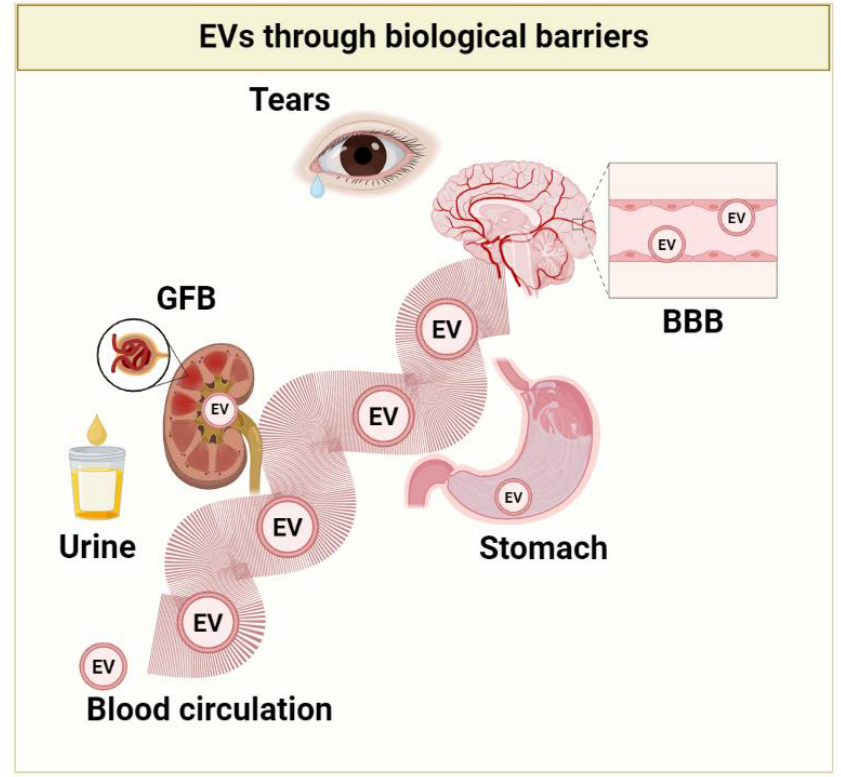
Figure 2. Summary of the different biologic barriers penetrated by EVs. GFB: glomerular filtration barrier; BBB: blood – brain barrier. Created in Biorender.com, accessed on 6 December 2022.